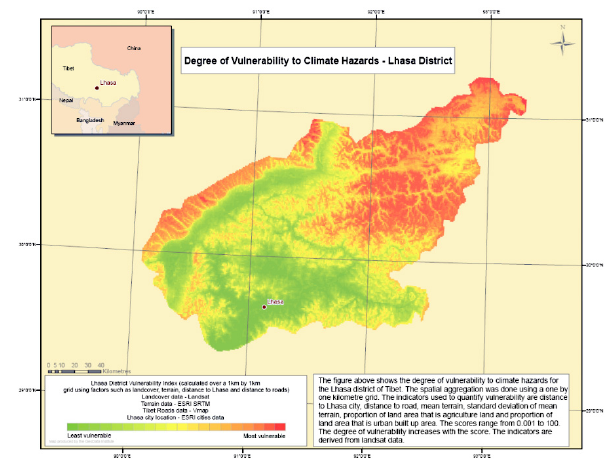
Figure 8. Tibet case study: Climate change hazard with associ- ated impacts on agricultural calendar / socioeconomic development. Based upon LANDSAT only.